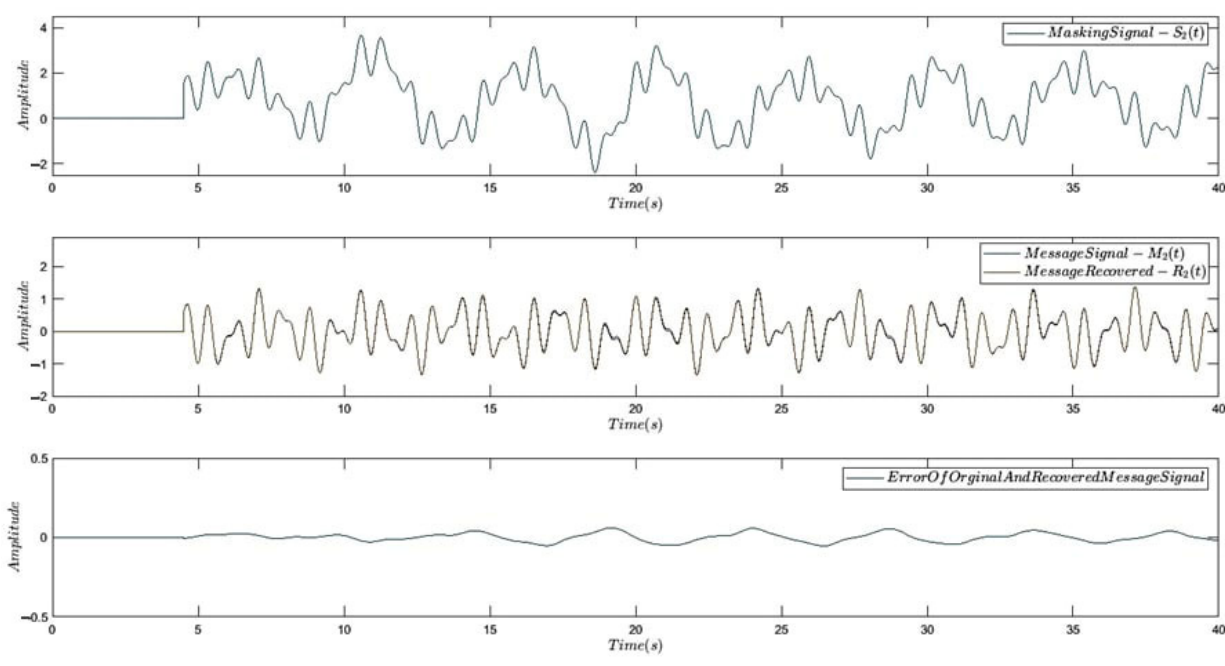
Figure 10. Message 2, masked and retrieved, and the error between these two signals. Table 1. Represents the mean square error of the main message signal and the retrieved signal.